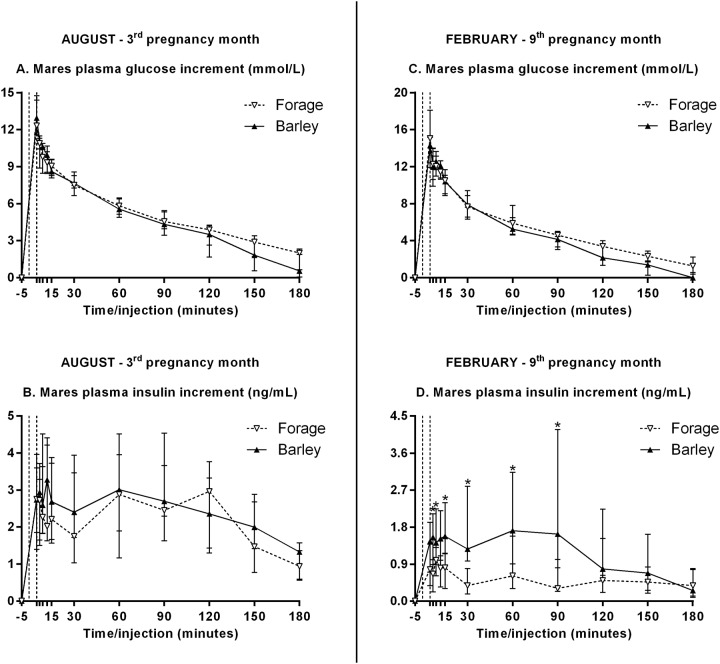
Mares’ plasma glucose and insulin increments (median and IQR) during IVGTT before (A, B) and after (C, D) start of the diet.The 5-min period between both dotted lines stands for the glucose injection time. Values under the asterisks significantly differ between both groups (Mann-Whitney with FDR adjustment).